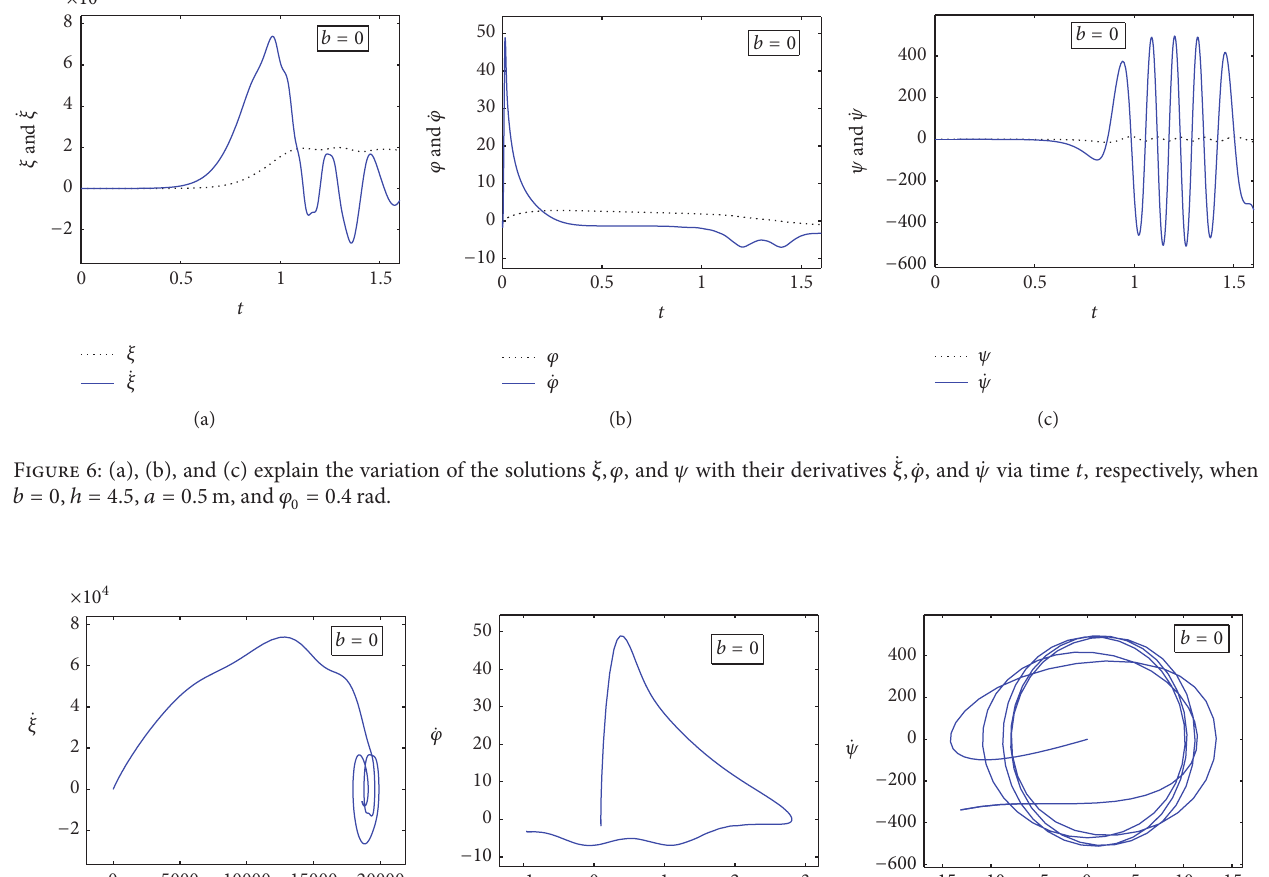
Figure 7: The phase plane diagrams between amplitudes and their velocities at 𝑏 = 0 , ℎ = 4.5 , 𝑎 = 0.5 m, and 𝜑 0 = 0.4 rad: (a) shows the ̇𝜉 influence of 𝜉 on , (b) shows the effect of 𝜑 on ̇𝜑 , and (c) shows the variation of 𝜓 with ̇𝜓